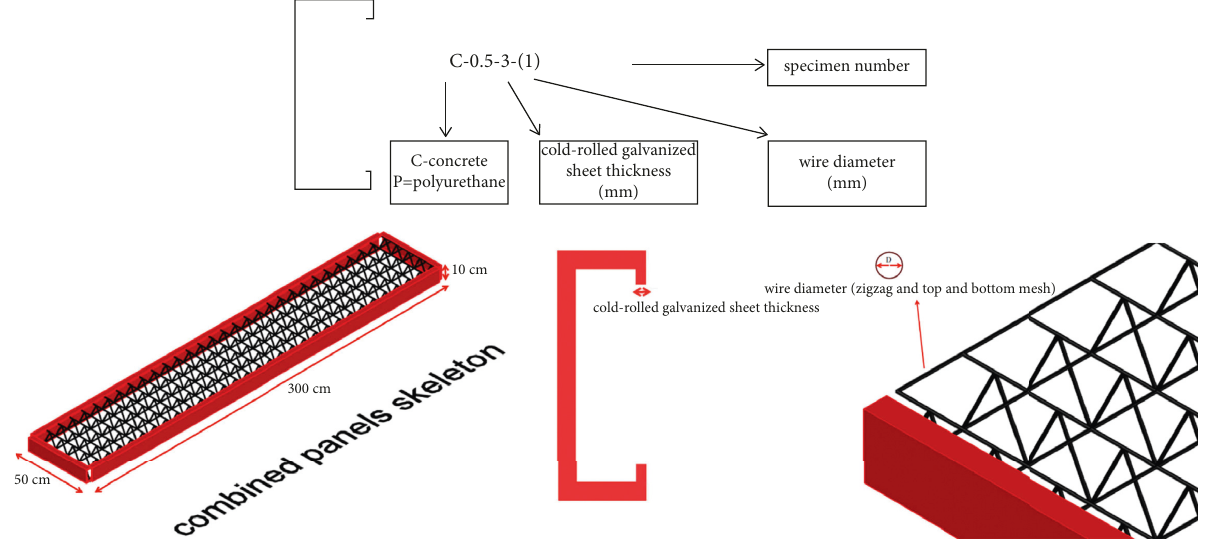
Figure 3: Panels’